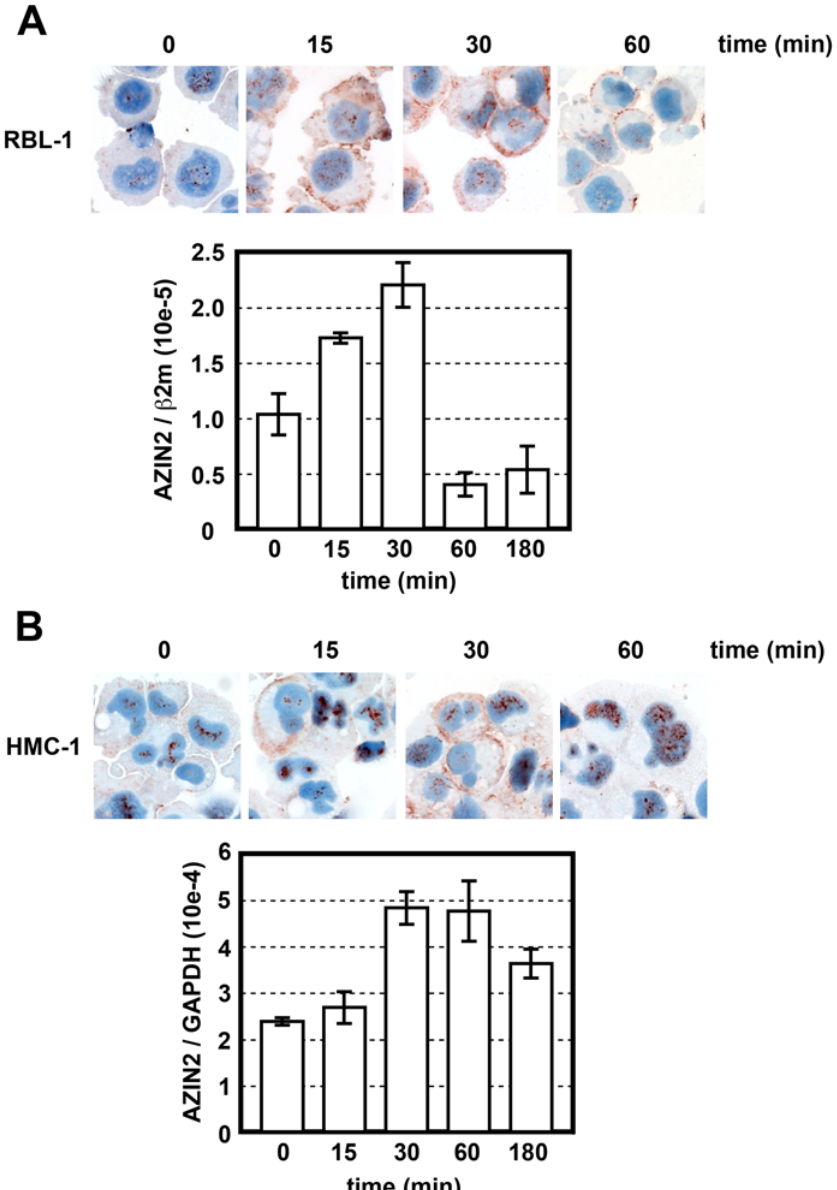
Figure 4. Upregulation and redistribution of AZIN2 in MCs during activation. RBL-1 (A) and HMC-1 (B) cells were activated with PMA and A23187 for the times indicated. After activation, the cells were either immunostained for AZIN2 (antiserum 2) or harvested for quantitative real-time PCR analysis of AZIN2. Relative mRNA levels are expressed as the ratio of AZIN2 mRNA level to that of either rat b -2-microglobulin ( b 2 m) or human glyceraldehyde-3-phosphate dehydrogenase (GAPDH). Original magnification of all immunostainings: 6